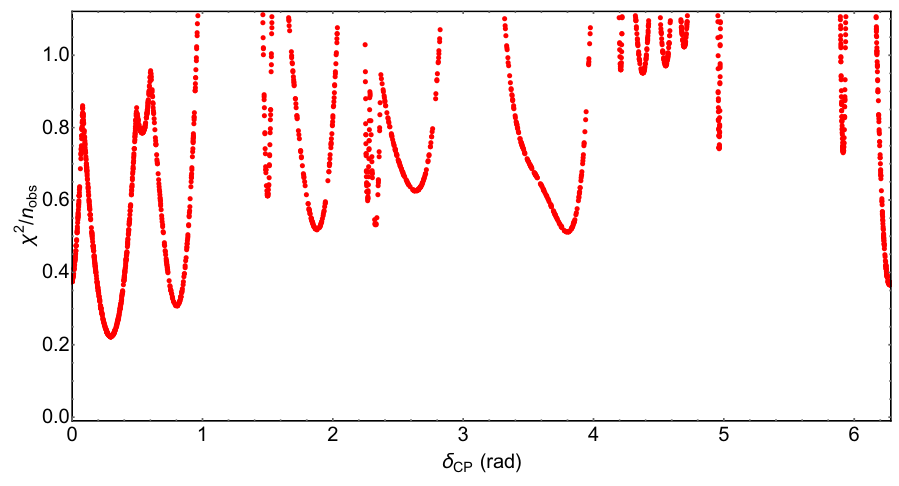
Figure 1 . Variation of the Dirac type CP violating phase (cid:14) CP in the neutrino sector by marginal- izing over all other model parameters. For this plot we restrict ourselves to the case of minimum of the total (cid:31) 2 20 (for 18 observables). (cid:20) with (cid:31) 2 per degree of freedom equal to 0.2. For example, if (cid:14) the model is still acceptable, with a local minimum that corresponds to (cid:31) 2 per degree of freedom around